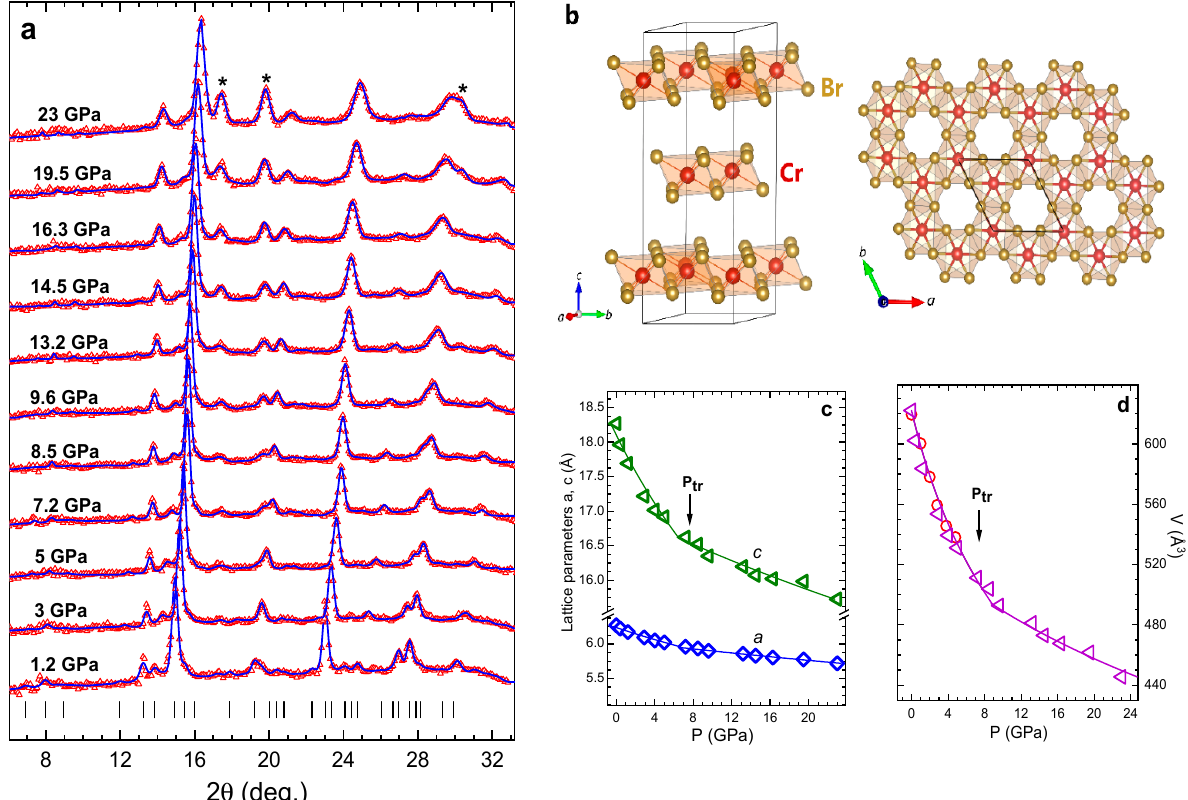
Figure 1. ( a ) X ‐ ray diffraction patterns of CrBr 3 obtained at selected pressures and ambient temperature, and refined by the Rietveld method. Experimental points and calculated profiles are shown. The tick below marks the calculated positions of the structural peaks of phase of rhombohedral phase of CrBr 3 . The asterisks (*) indicate additional diffraction peaks from the rhenium gasket; ( b ) Schematically representation of rhombohedral crystal structure of CrBr 3 . The unit cell ( left ) and top view ( right ) are shown. The orientation of the crystallography axes is presented; ( c ) The lattice parameters of CrBr 3 as a function of pressure. The phase transition pressure P tr is labeled. The solid lines are linear fit of experimental data; ( d ) The pressure dependence of unit cell volume of the ambient and high ‐ pressure phases of CrBr 3 , fitted by the third order Birch ‐ Murnaghan equation of state (1). The red circles represent the obtained values for unit ‐ cell volume from ND data (see below).